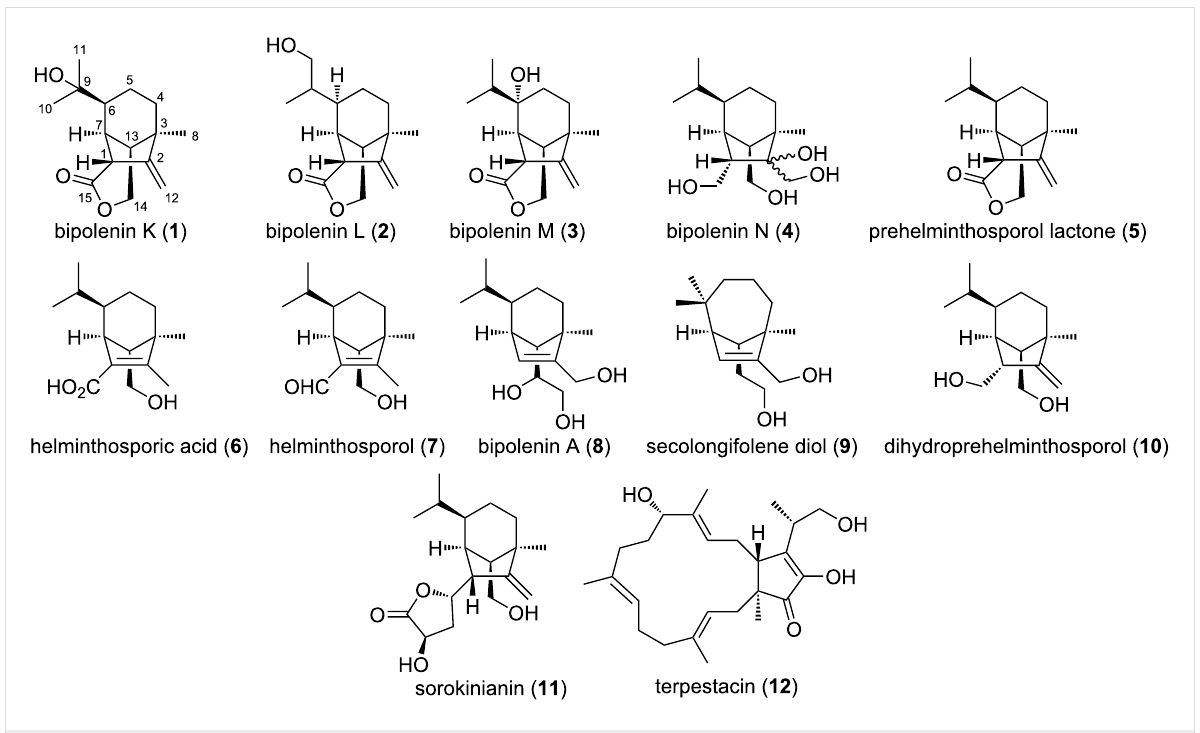
Figure 1: Structures of compounds 1 – 12 isolated from B. sorokiniana